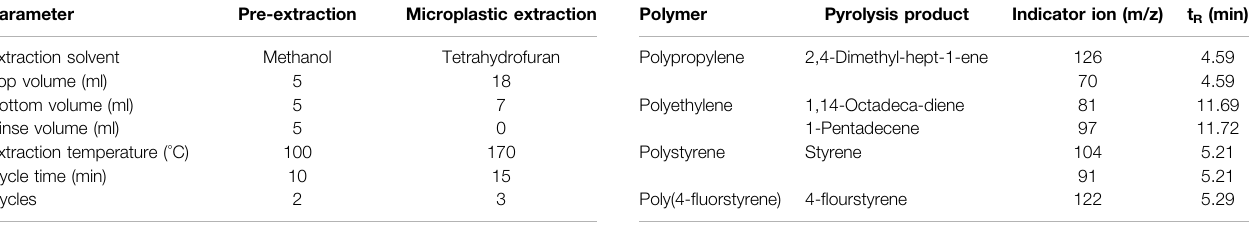
TABLE 1 | Parameters of the pressurized liquid extraction for the pyr-GC-MS analysis.